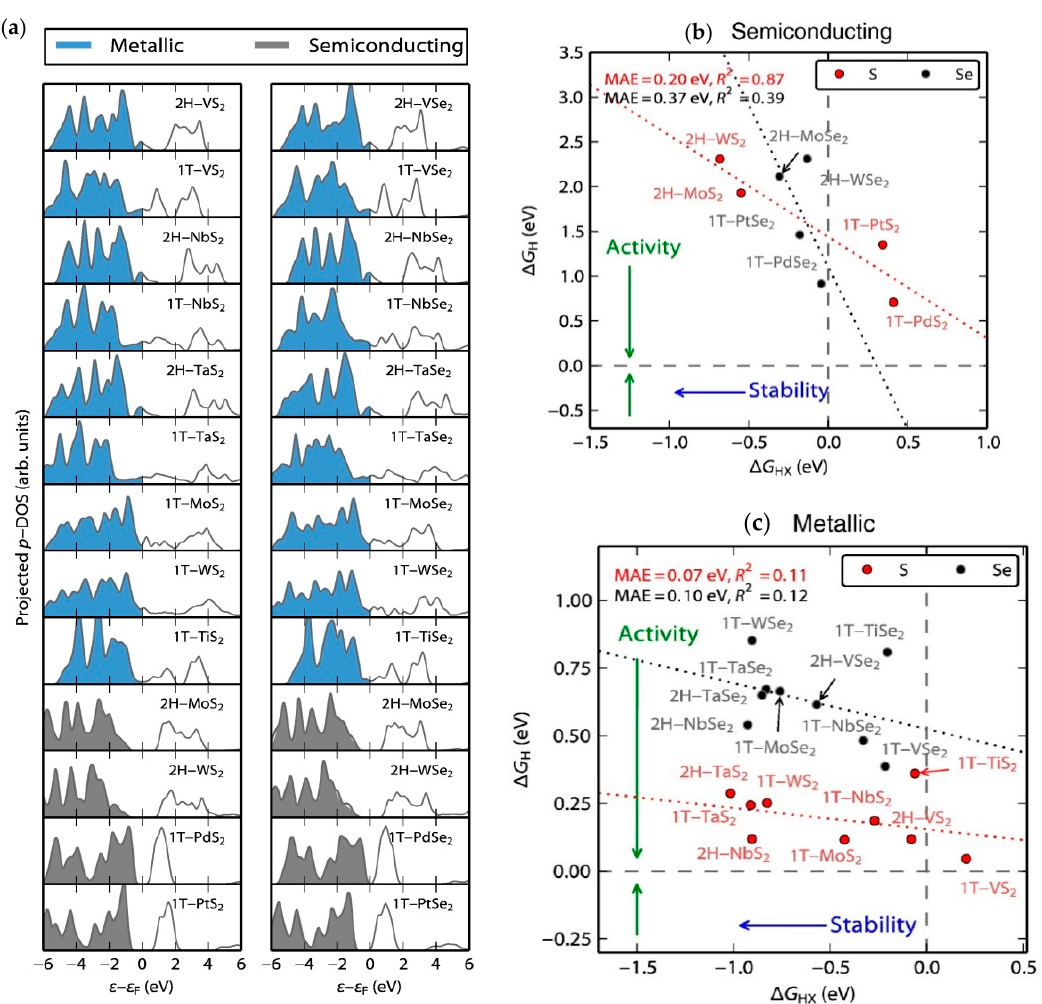
Figure 17. ( a ) p-projected density of states on the S or Se atom for 2D TMDs in the 2H and 1T structures relative to the Fermi level, with blue indicating metallic basal planes, while grey ones are semiconducting, ( b ) Semiconducting single-layered TMD basal planes, ( c ) Metallic single-layered TMD basal planes. Reprinted with permission from [176]. Copyright 2015, Elsevier .